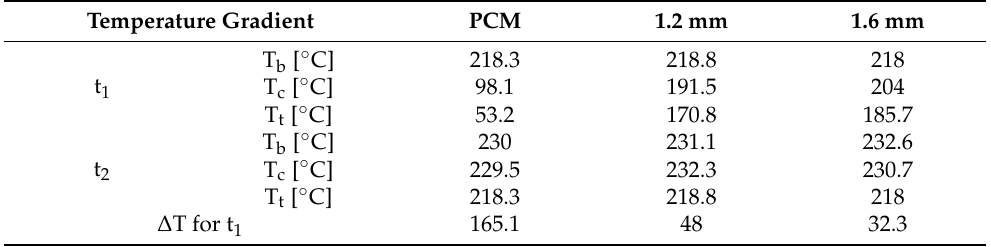
Table 4. Temperature values for used thermocouples (b—bottom h = 12 mm, c—center h = 50 mm, t—top h = 87 mm) at the time t 1 and t 2 (from Table 1) for the application of different enhancers. Temperature Gradient